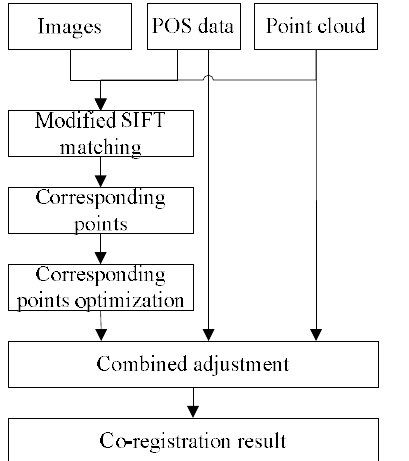
Figure.1 Workflow of the proposed co-registration method